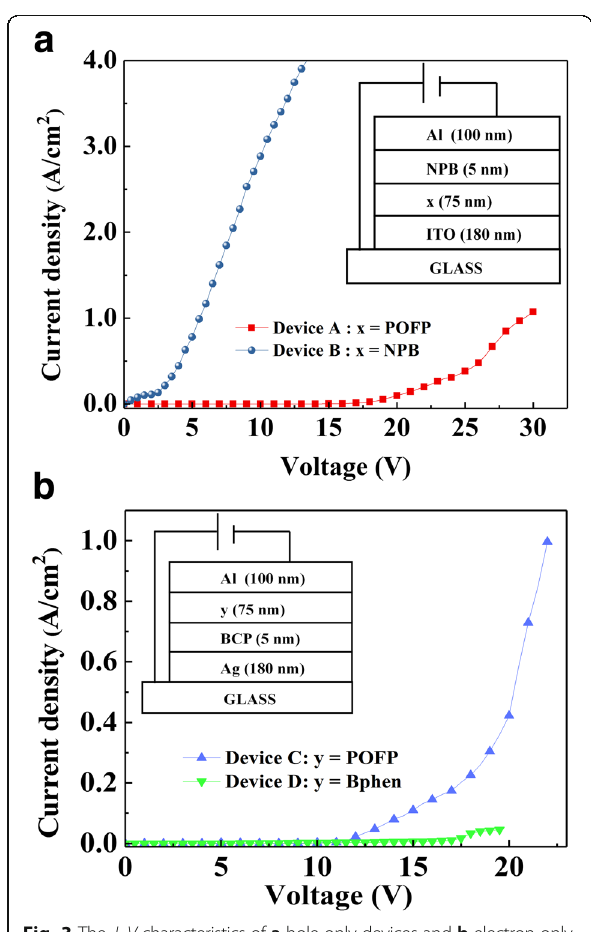
Fig. 4 The EL spectrum of AND:2wt%DSA-ph and the absorbance spectrum of